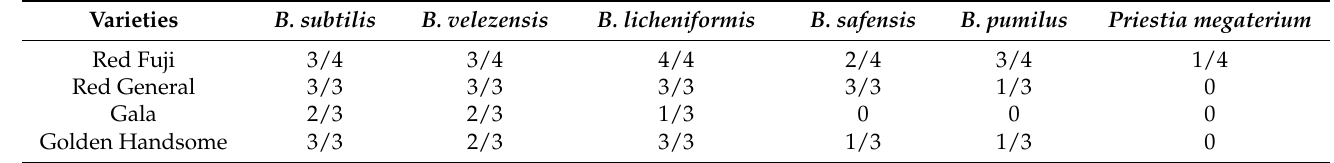
Table 2. Distribution frequency of CEB types in apple